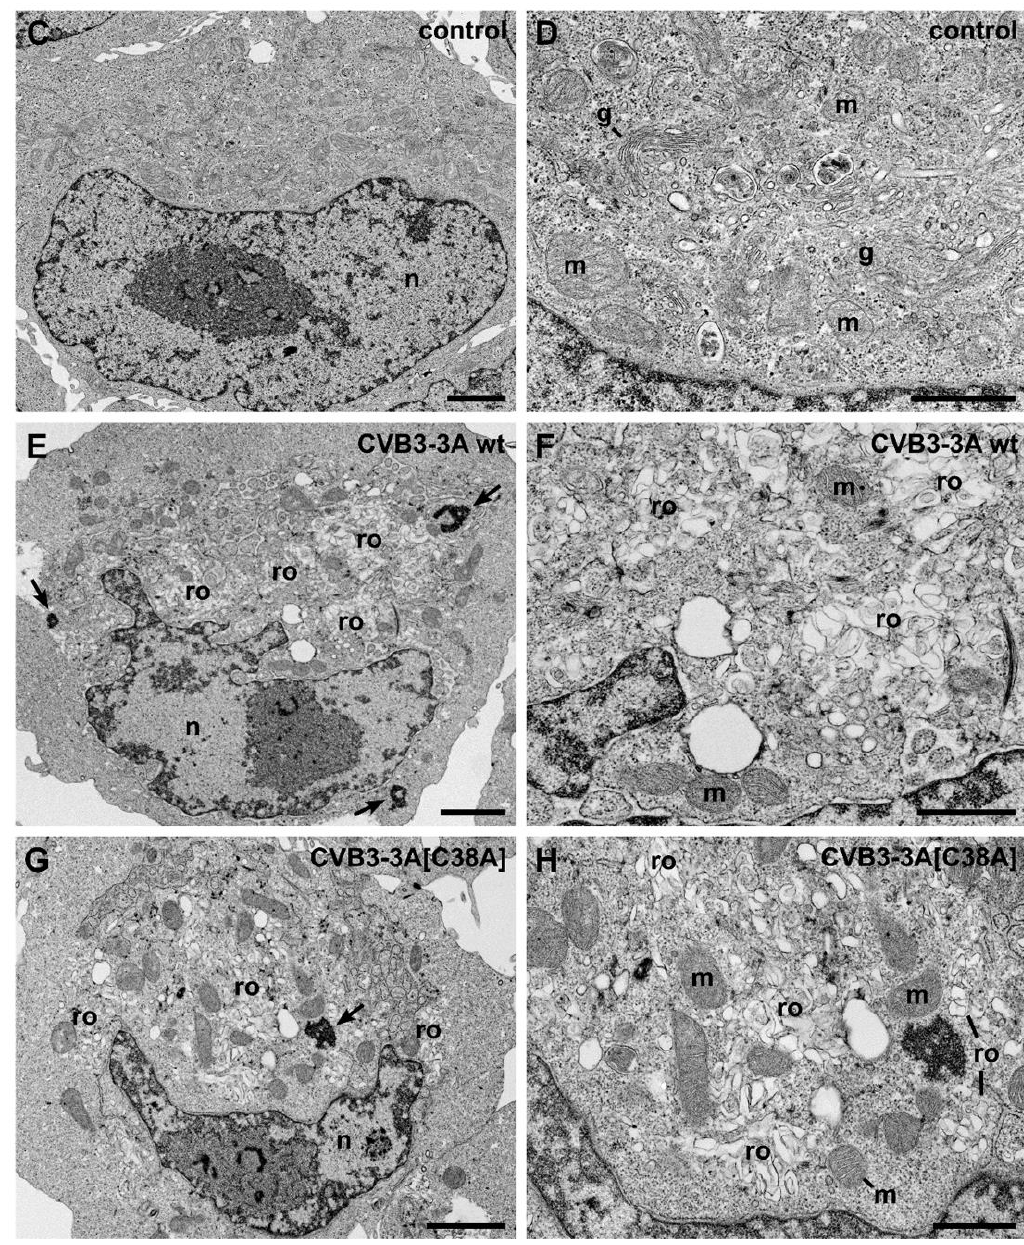
Figure 1. Effect of cysteine 38 of protein 3A at the ultrastructural level. ( A ) HeLa cells were infected with GFP-CVB3 encoding protein 3A wt or 3A[C38A] at MOI 1 for 16 h and processed for the immunoblotting of protein 3A. ( B ) Fractionation of non-infected cells and cells infected with GFP-CVB3 variants (3A wt and 3A C38A) at MOI 1 for 5 h. Pre-cleared lysates in hypotonic lysis buffer were subjected to differential centrifugation at 16,000 rcf (16 k) and 120,000 rcf (120 k). Resulting membrane pellets and supernatants were analyzed by the immunoblotting of 3A-interactor ACBD3, loading control GAPDH. Quantification of indicated immunosignals in 16k-rcf membrane pellets ( n = 4). n.s.—not significant. ( C – G ) Thin-section electron microscopy of HeLa-cells after infection with either GFP-CVB3-3A wt or GFP-CVB3-3A[C38A]. ( C , D ) Non-infected cells (control). ( E – H ) Cells infected with GFP-CVB3-3A wt ( E , F ) or GFP-CVB3-3A[C38A] ( G , H ). Images in the right